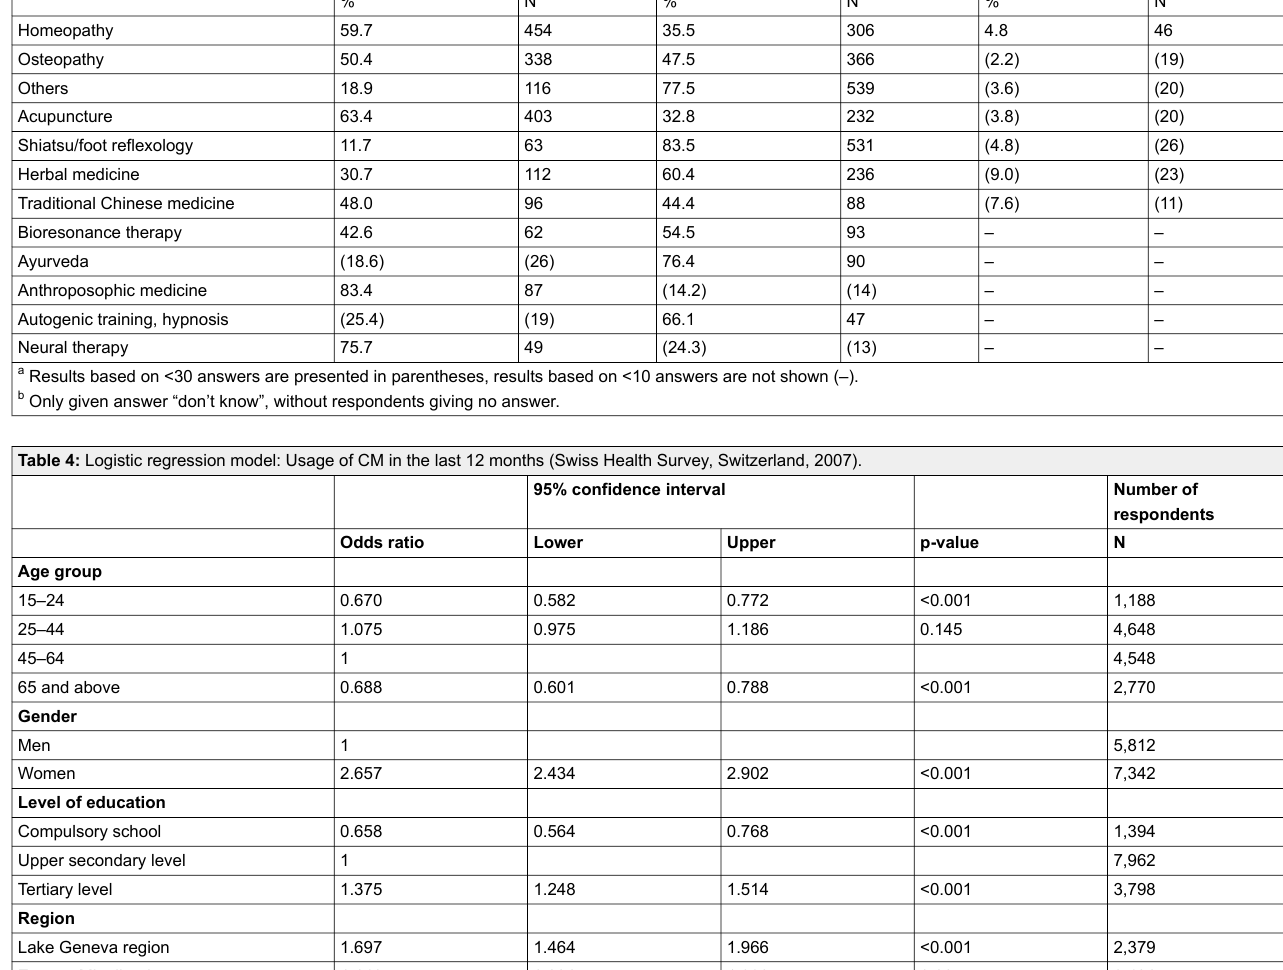
Table 3: Visiting a certified physician or a non-medical therapist for CM treatments in the last 12 months regarding CM method (Swiss Health Survey, Switzerland, 2007) a . Method